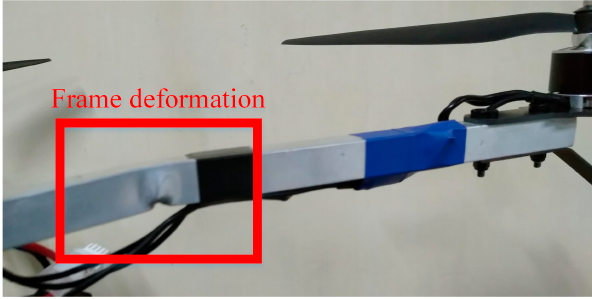
Figure 17 . Experimental system. Figure 17. Experimental system.